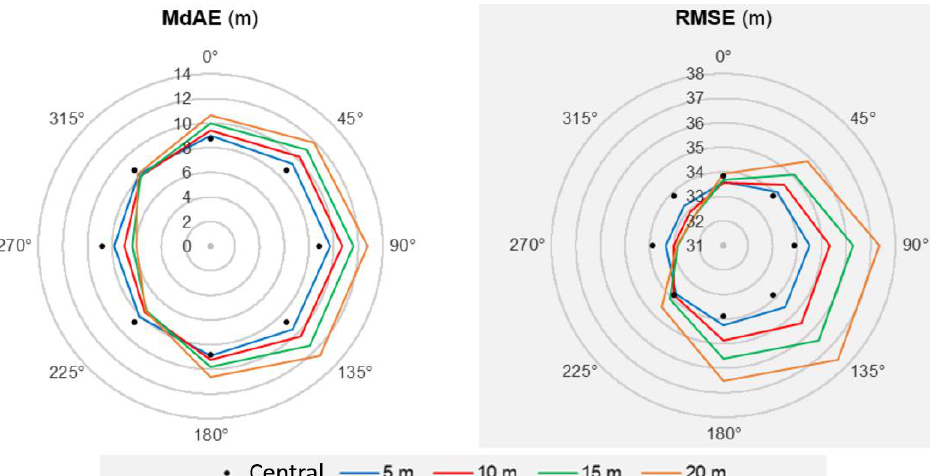
Figure 14. Accuracy metrics changes of terrain heights with respect to shift magnitude and direction. Black dots are the original accuracy metrics without